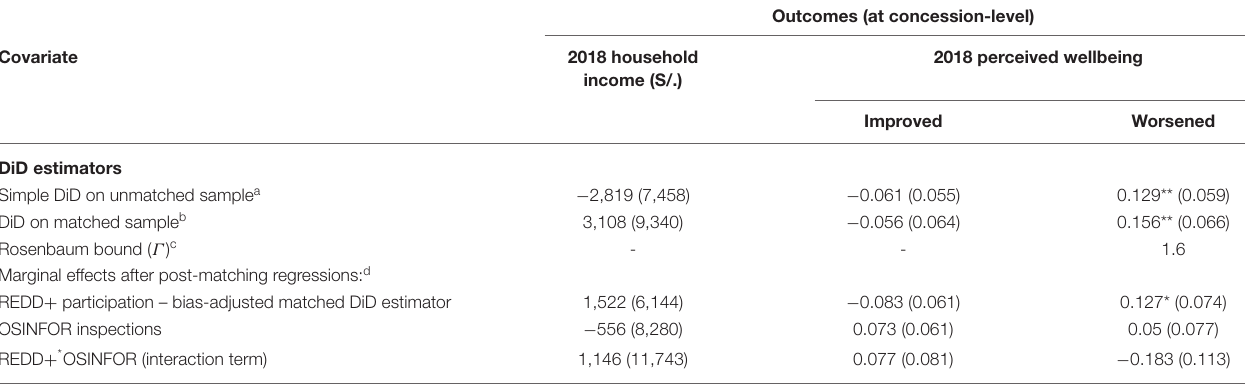
TABLE 4 | Singular and combined effects of the Madre de Dios REDD + project and OSINFOR inspections on household wellbeing.